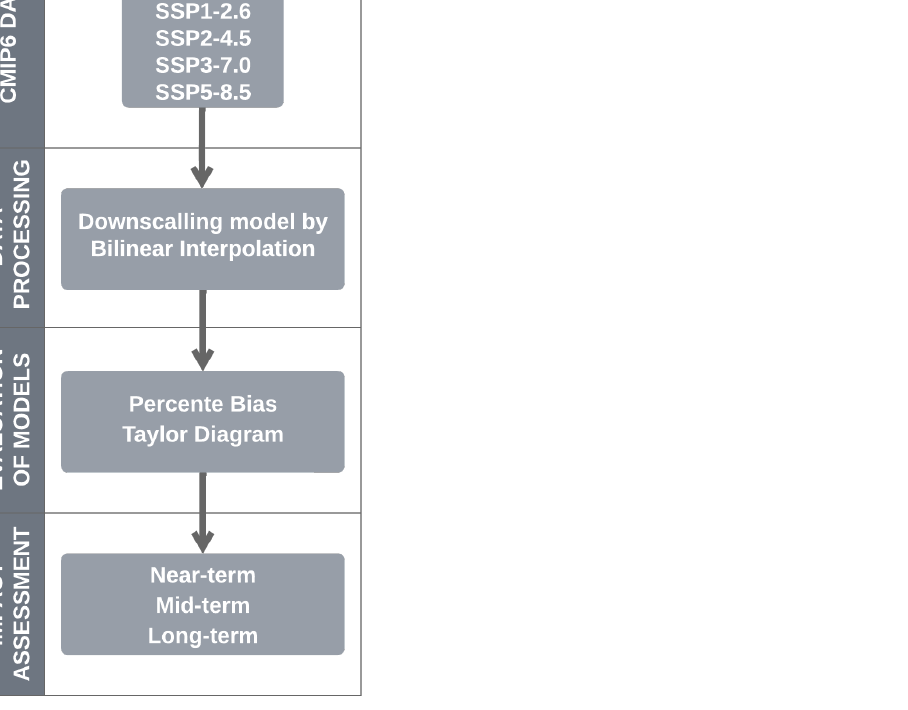
Figure 2. Flowchart illustrating the steps applied in this study to obtain projections of climate change scenarios.